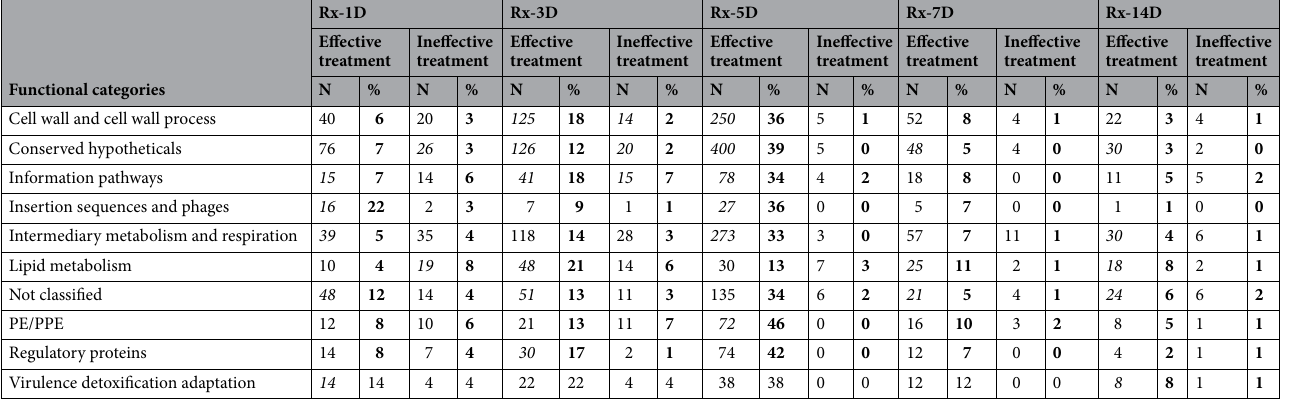
Table 1. Distribution of genes based on functional categories as categorized by mycobrowser. N -Detected genes in each category, % percentage; numbers in bold represent the percentage of dysregulated gene calculated based on the number of genes in the particular functional category, numbers in italics indicate the significantly dysregulated functional categories. Rx-1d–Rx-14d – Days post-treatment initiation.